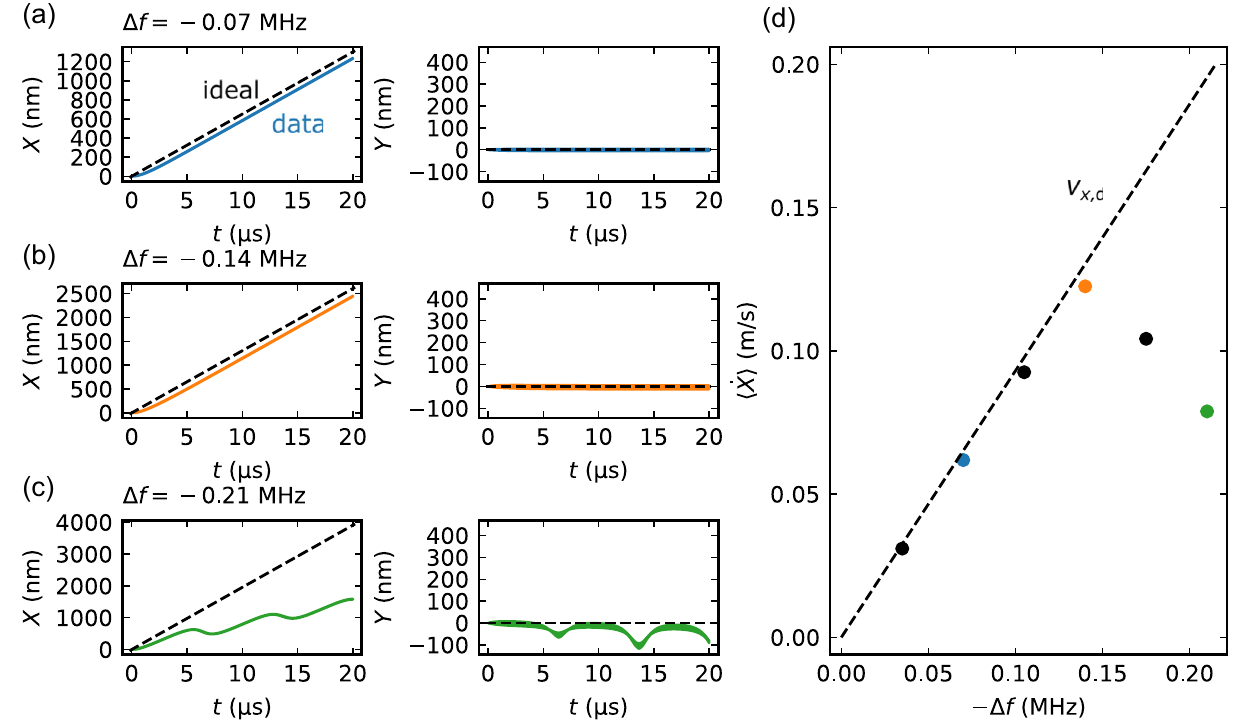
Figure 4. ( a )–( c ) Straight motion of skyrmion driven by SAWs. Here, the frequency of the standing SAW 0.07 MHz; ( b ) 0.14 MHz, and ( c ) 0.21 MHz. The solid curves in the x direction is detuned: ( a ) (cid:31) f x = − − − indicate the simulated results of the skyrmion trajectory (denoted by “data”), and dashed ones the trajectory of the intersections of antinodes trapping the skyrmion (denoted by “ideal”). See also Supplementary Movie 2. X ( d ) Averaged velocity of skyrmion along the x direction as a function of the amplitude of detuning (cid:31) f x . The � ˙ � dashed line shows v x , d calculated using Eq. nodes. To show this, let us consider the case in which the frequency of the standing SAW in the x -direction is �ω x / 2 π . Here � f y �ω y / 2 π 0 in this section. detuned to � f x = = = Figure 4(a)–(c) shows the time ( t ) dependence of the skyrmion position ( X and Y coordinates) at three (cid:31) f x 0.07 MHz, 0.14 MHz, and 0.21 MHz). Note that the skyrmion dynamics and the force field values ( (cid:31) f x = − − − F ( R , t ) are also shown in Supplementary Movie 2 in detail. For (cid:31) f x = − 0.07 MHz and − 0.14 MHz, the skyr- mion moves along the x direction almost following the motion of antinodes, as shown in Fig. 4(a) and (b). The (cid:31) f x 0.14 change in the X coordinate is almost proportional to time. The velocity of skyrmion is faster for | | = (cid:31) f x 0.07 MHz. In the Y direction, in contrast, the skyrmion hardly moves even up to 20 µ s. This MHz than | | = (cid:31) f x result means that the skyrmion moves in straight lines along the direction of the detuned SAW. When the | | value increases to 0.21 MHz, the situation changes dramatically, as shown in Fig. 4(c). The skyrmion no longer follows the antinode motion and starts to move also along the Y direction. To discuss the skyrmion motion, we consider the Galilean transformation with the velocity v x , d :